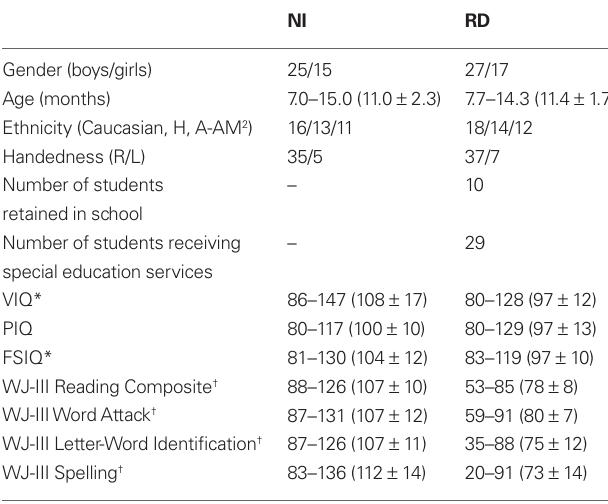
Table 1 | Demographic data, educational history, and performance on standardized tests for students with reading difficulties (RD) and non-reading impaired students (NI; range, mean and SD in